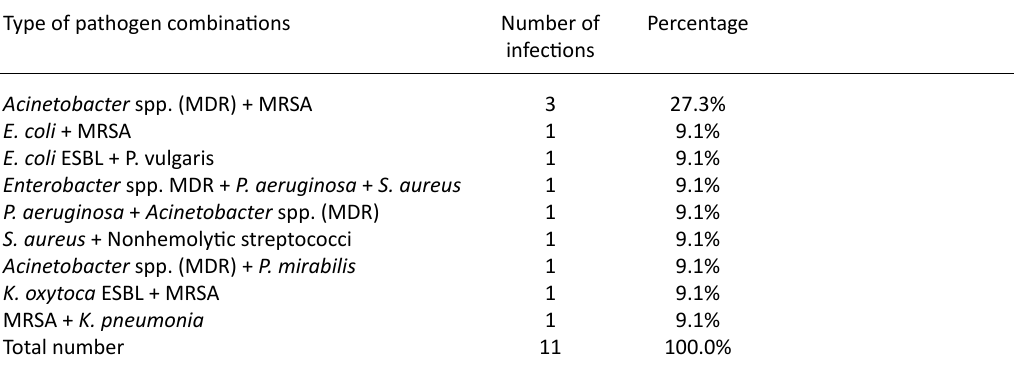
Table 5. Percentage of mixed wound infections Number of Percentage of mixed Note mixed infections wound infections 11 3.3% All were diabetic patients Table 6. Types of pathogen combinations for the mixed wound infections Type of pathogen combinations Number of Percentage